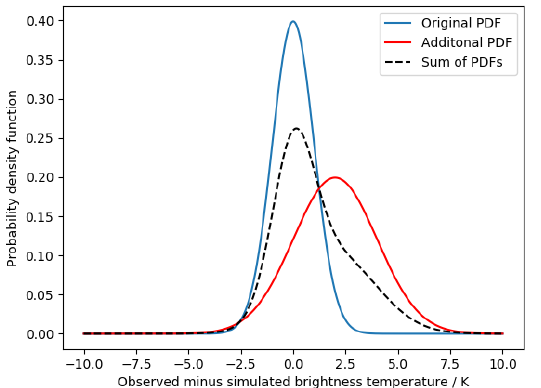
Figure 1. Gaussian mixture model illustration: the original PDF (blue) and additional PDF (red) are added to give a new PDF (black dashed line). The new PDF is centered on the sum of the mean and sigma of the original PDF and has a sigma twice that of the original PDF.